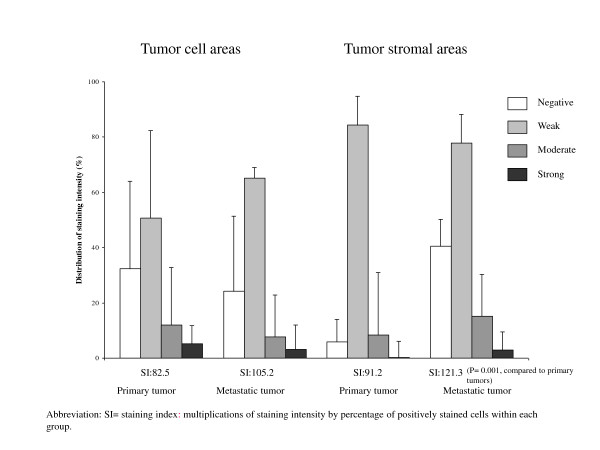
Expression of COX-2 in primary and metastatic tumors.